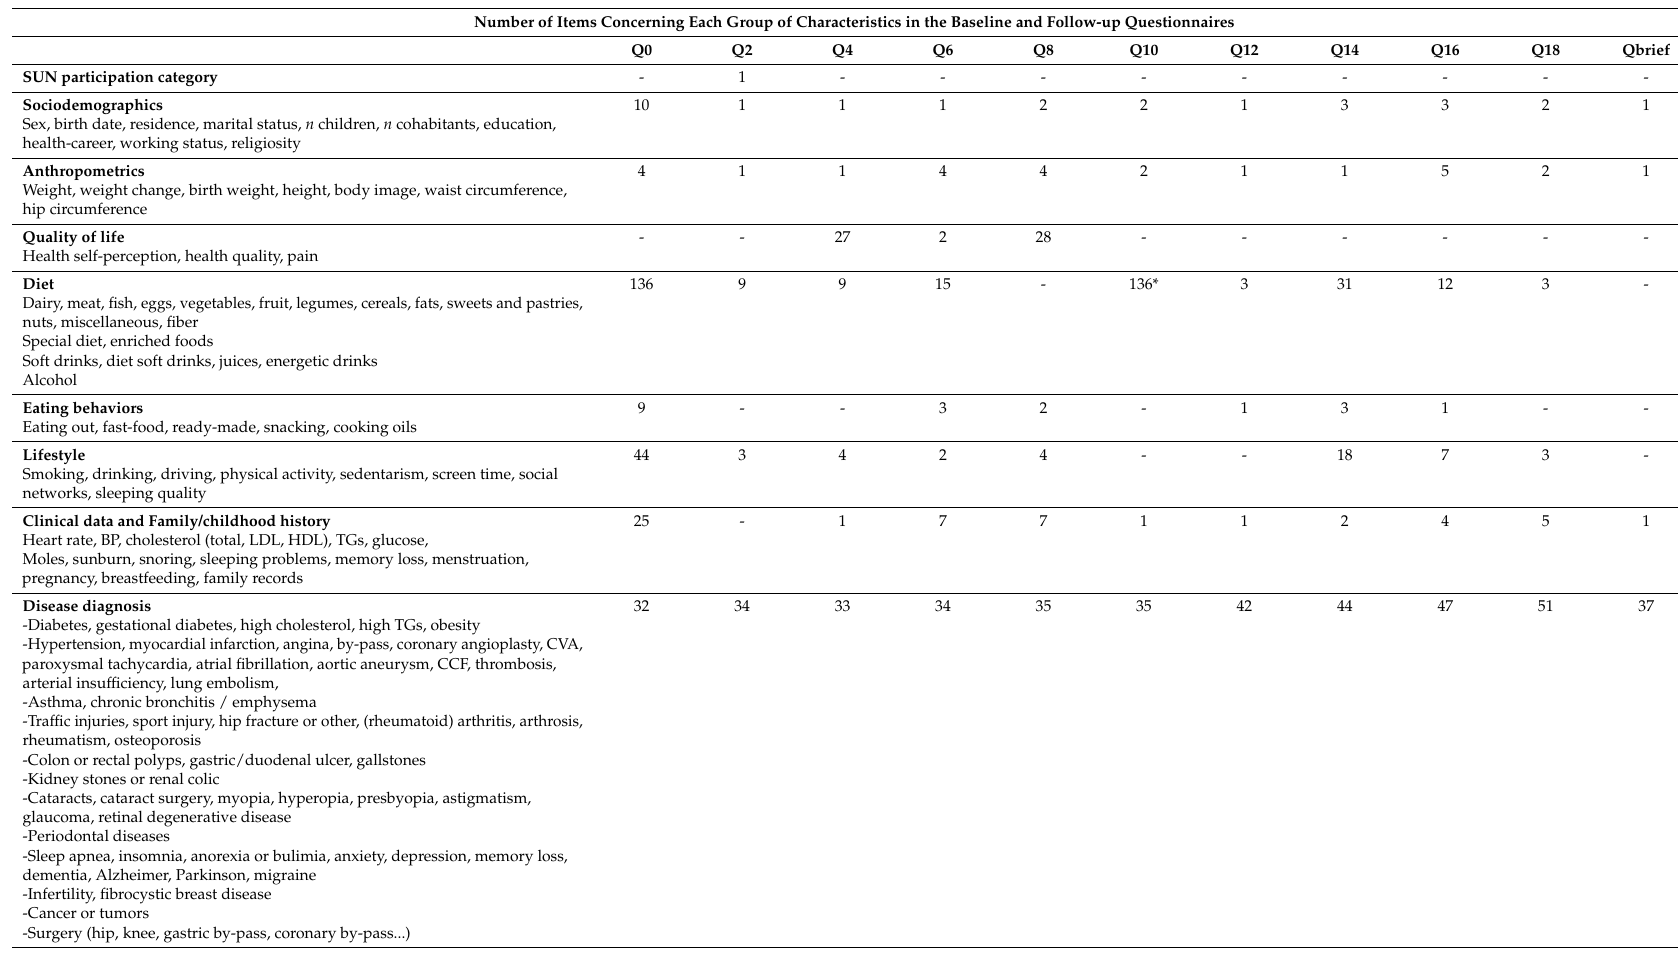
Table 1. Items included in the baseline questionnaire (Q0) and in the follow-up questionnaires after 2, 4 . . . , and 18 years (Q2 to Q18). Number of Items Concerning Each Group of Characteristics in the Baseline and Follow-up